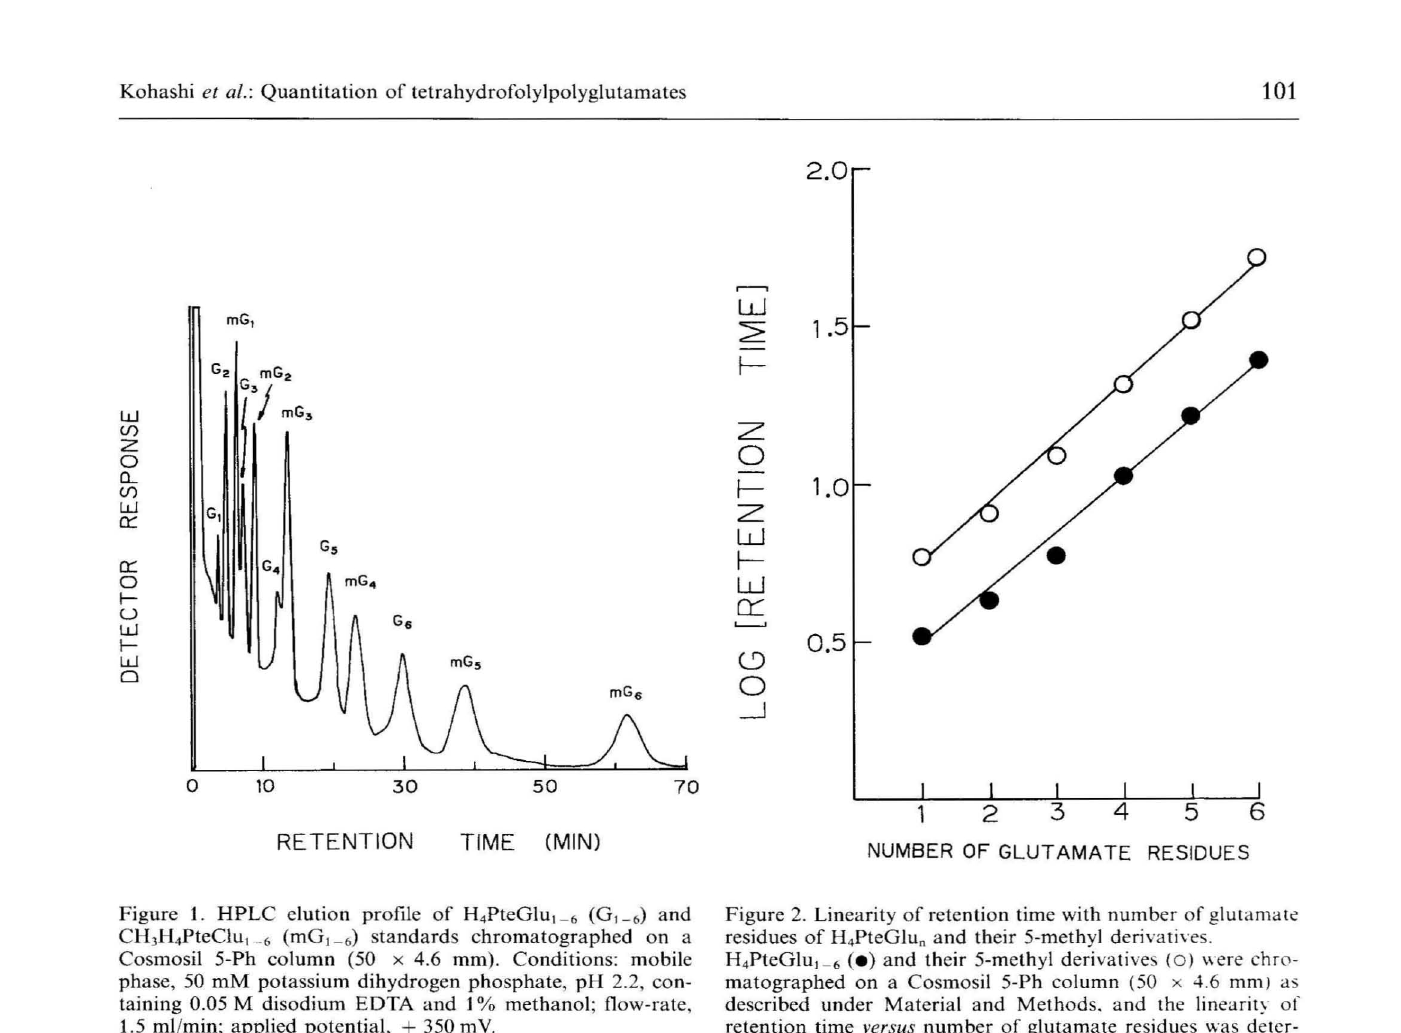
Figure 1. HPLC elution profile of H 4 PteGlu' _6 (G'-6) and CH 3 H 4 PteClu' .6 (mG,_6) standards chromatographed on a Cosmosil 5-Ph column (50 x 4.6 mm). Conditions: mobile phase, 50 mM potassium dihydrogen phosphate, pH 2.2, con taining 0.05 M disodium EDTA and 1 % methanol; flow-rate, 1.5 ml/min; applied potential, + 350 mY.